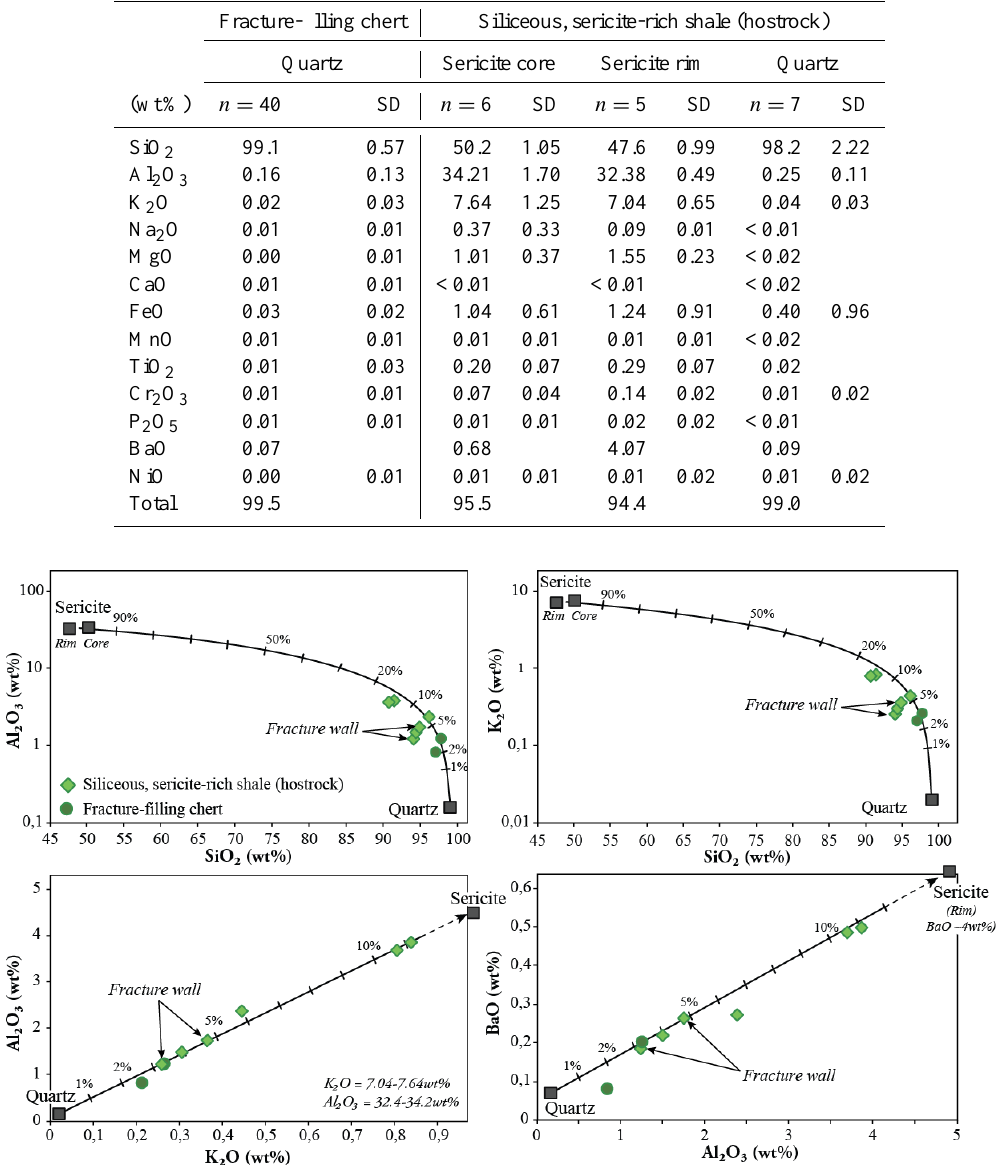
Table 2. In situ microprobe analyses of various components in Barite Valley fracture-filling cherts and surrounding silicified shales (SD = standard deviation).